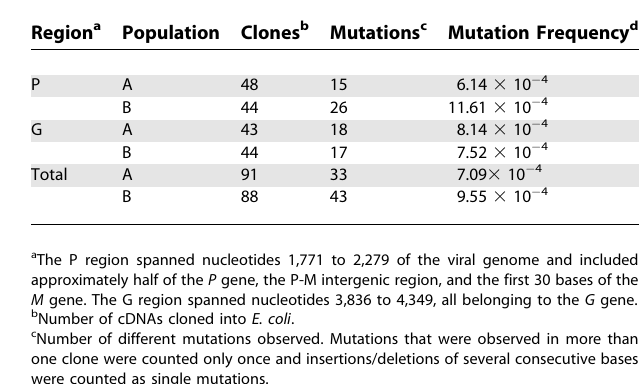
Table 2. Genetic Variability of the VSV Populations A and B in the Presence of the Mutagenic Base Analog 5-FU